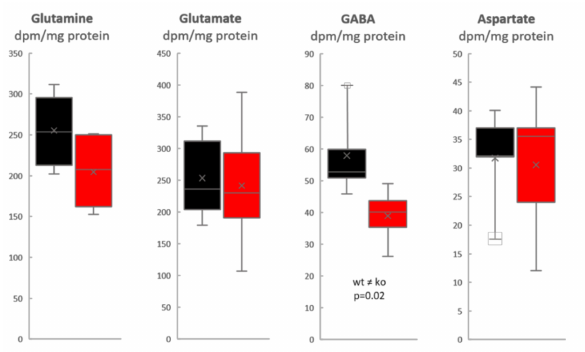
Figure 1. Significant reduction in the newly formed GABA from the astroglia-specific metabolite acetate in Slc38a1 − / − mice. Slc38a1 +/+ and Slc38a1 − / − mice were given an intraperitoneal injection of [2- 14 C]acetate and sacrificed 10 min after injection to assess the capability of Slc38a1 − / − (red) and Slc38a1 +/+ (black) mice to synthesize glutamine, glutamate, GABA and aspartate. Values are given as radioactivity / mg protein to show changes in newly made amino acids. Glutamine, glutamate and aspartate are made to the same degree in both genotypes. In contrast, there is a significant reduction in the newly synthesized GABA in Slc38a1 − / − ( p = 0.02, two-sided paired Student’s t -test). Data are presented as box-and-whisker plots (Excel): whisker is range (highest and lowest observed value), × is mean (average), – is median, box is the interquartile range (middle 50% of the observed values); n = 4 mice of each genotype for GABA and glutamine, n = 5 mice of each genotype for glutamate and aspartate.